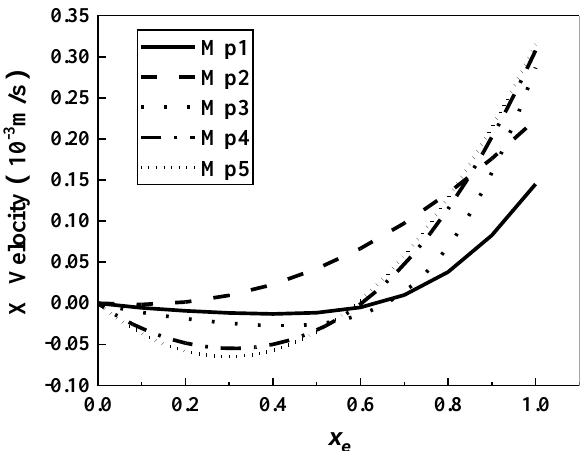
Figure 9. Velocity distribution along the y-direction at the middle position. The x e = 0.5 in the micropit.